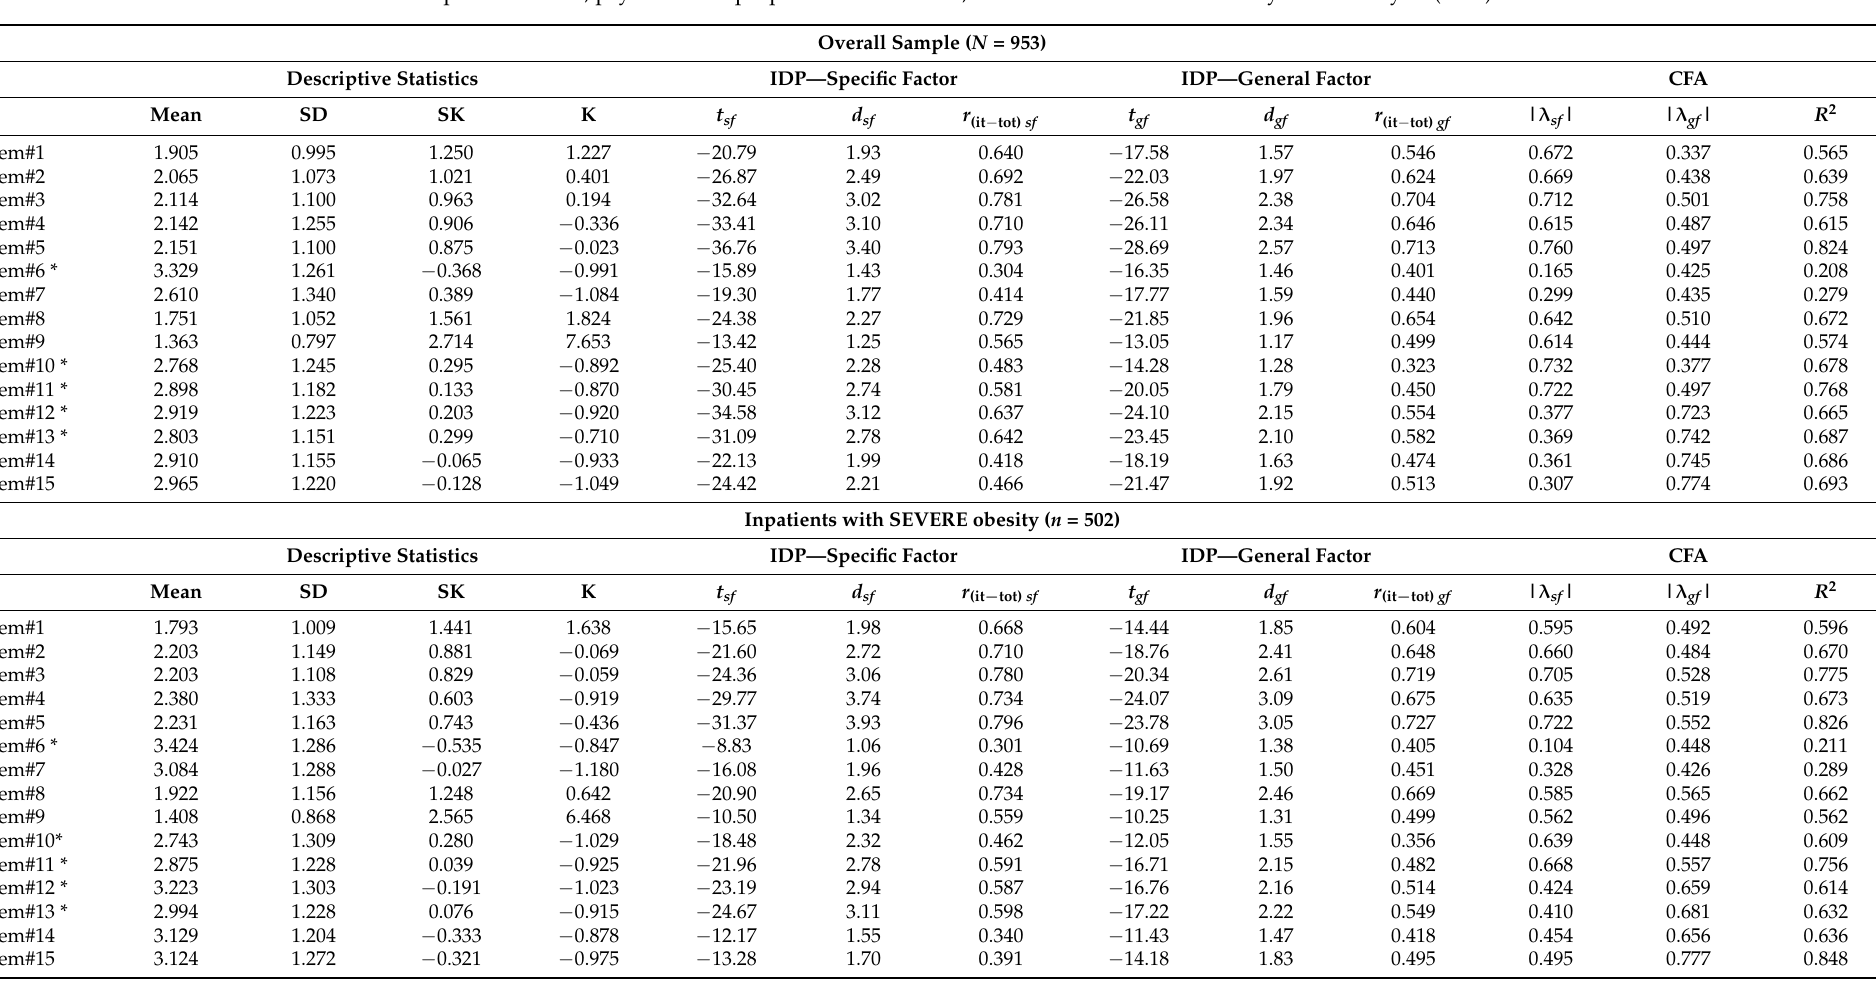
Table 1. Descriptive statistics, psychometric properties of each item, and results of the confirmatory factor analysis